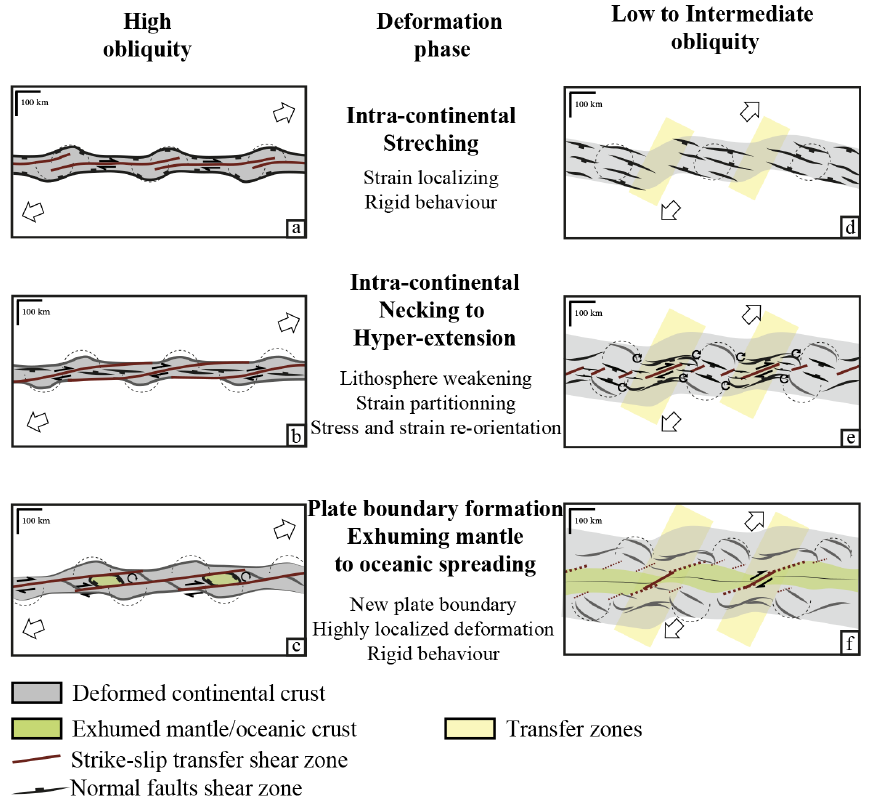
Figure 12. Schematic showing the simplified evolution of intra-continental deformation leading to the formation of strike-slip and transform margins for high and intermediate to low obliquity based on numerical model results.